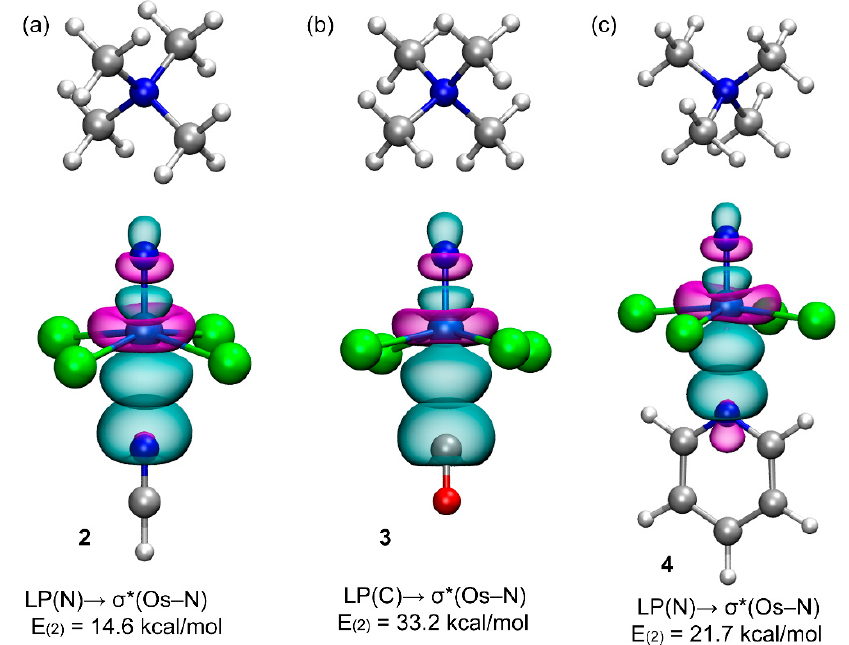
Figure 4. Representation of the NBOs corresponding to the LP → σ * donor–acceptor interactions in the OmB complexes 2 ( a ), 3 ( b ) and 4 ( c ). The isosurface used for the MOs is 0.008 a.u.